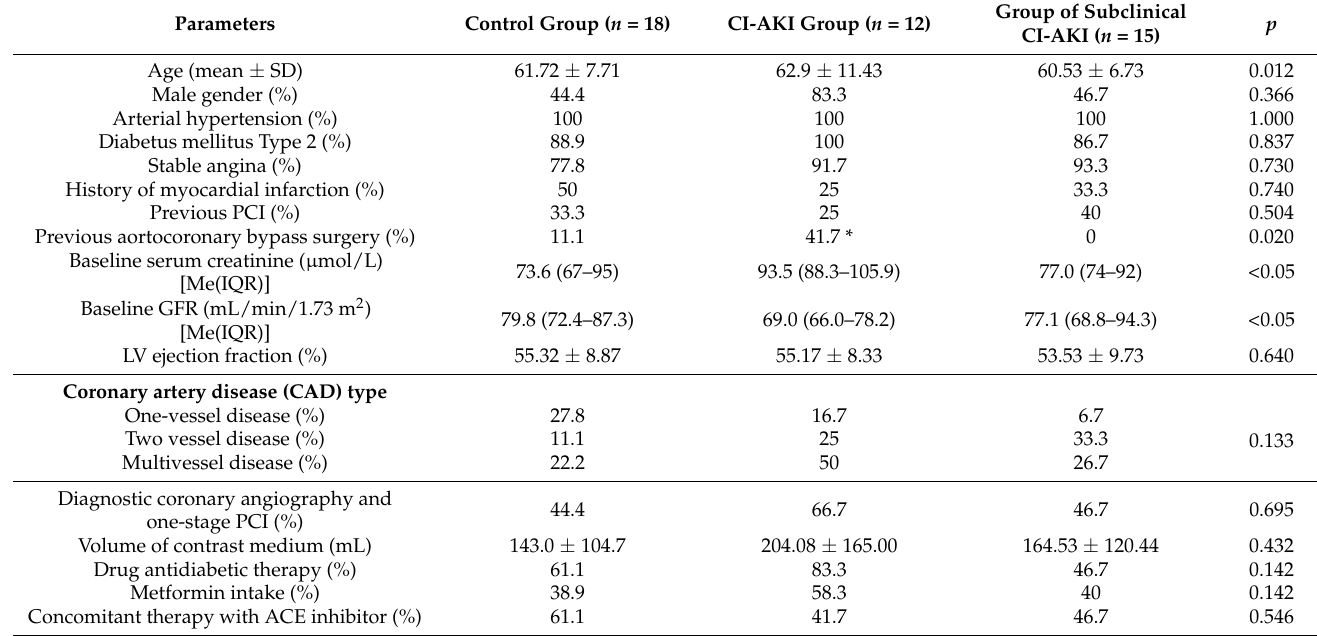
Table 1. The main clinical characteristics of the studied patients by